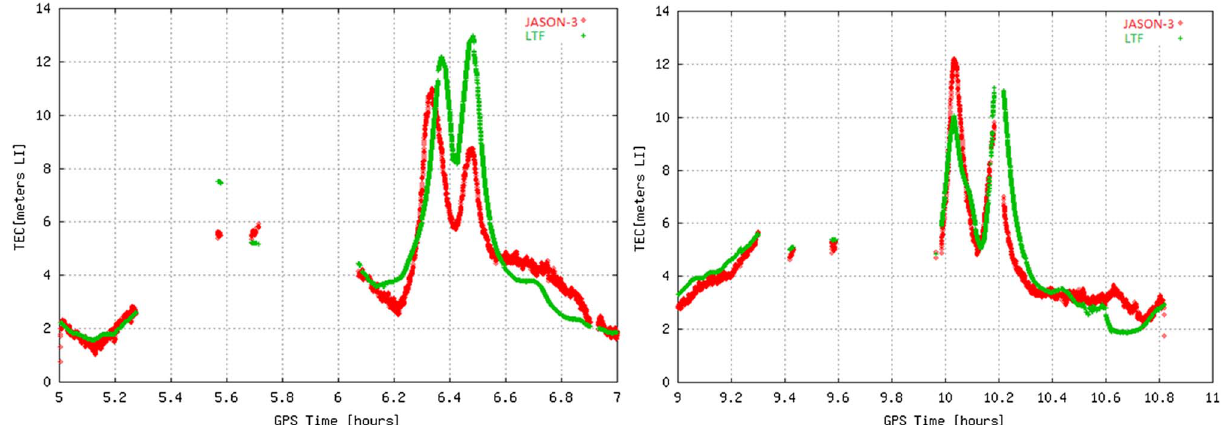
Fig. 13. Example of direct comparison between smoothed TEC measurements from JASON-3 altimeter and forecasted TEC maps for 14 January 2018. (a) GPS time from 5 to 7 h. (b) GPS time from 9 to 11 h.